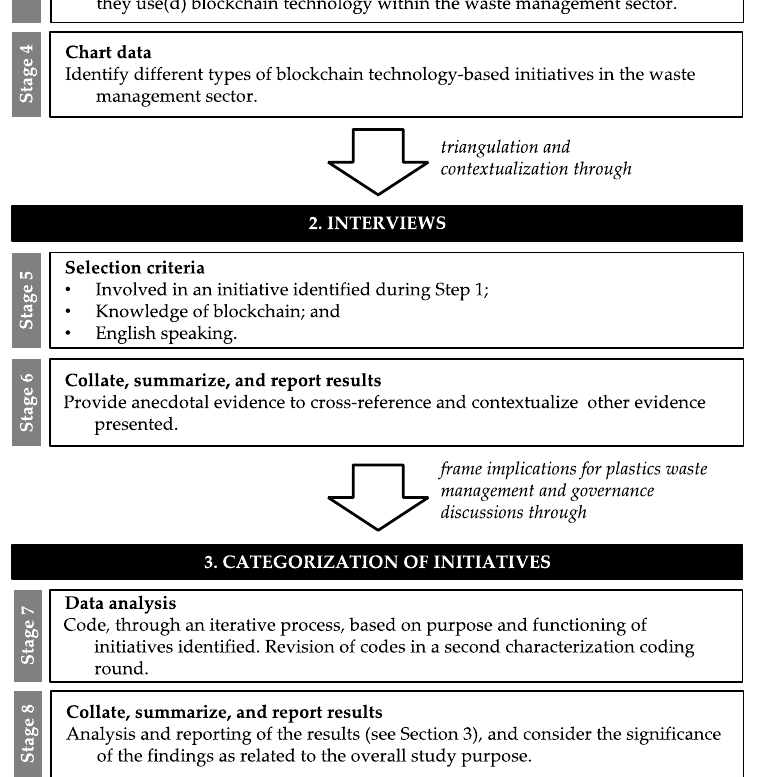
Figure 1. Overview of the three-step process: ( 1 ) scoping review methodology adapted from Arksey and O’Malley (2005) and Levac et al. (2010); ( 2 ) interviews; and ( 3 ) categorization of